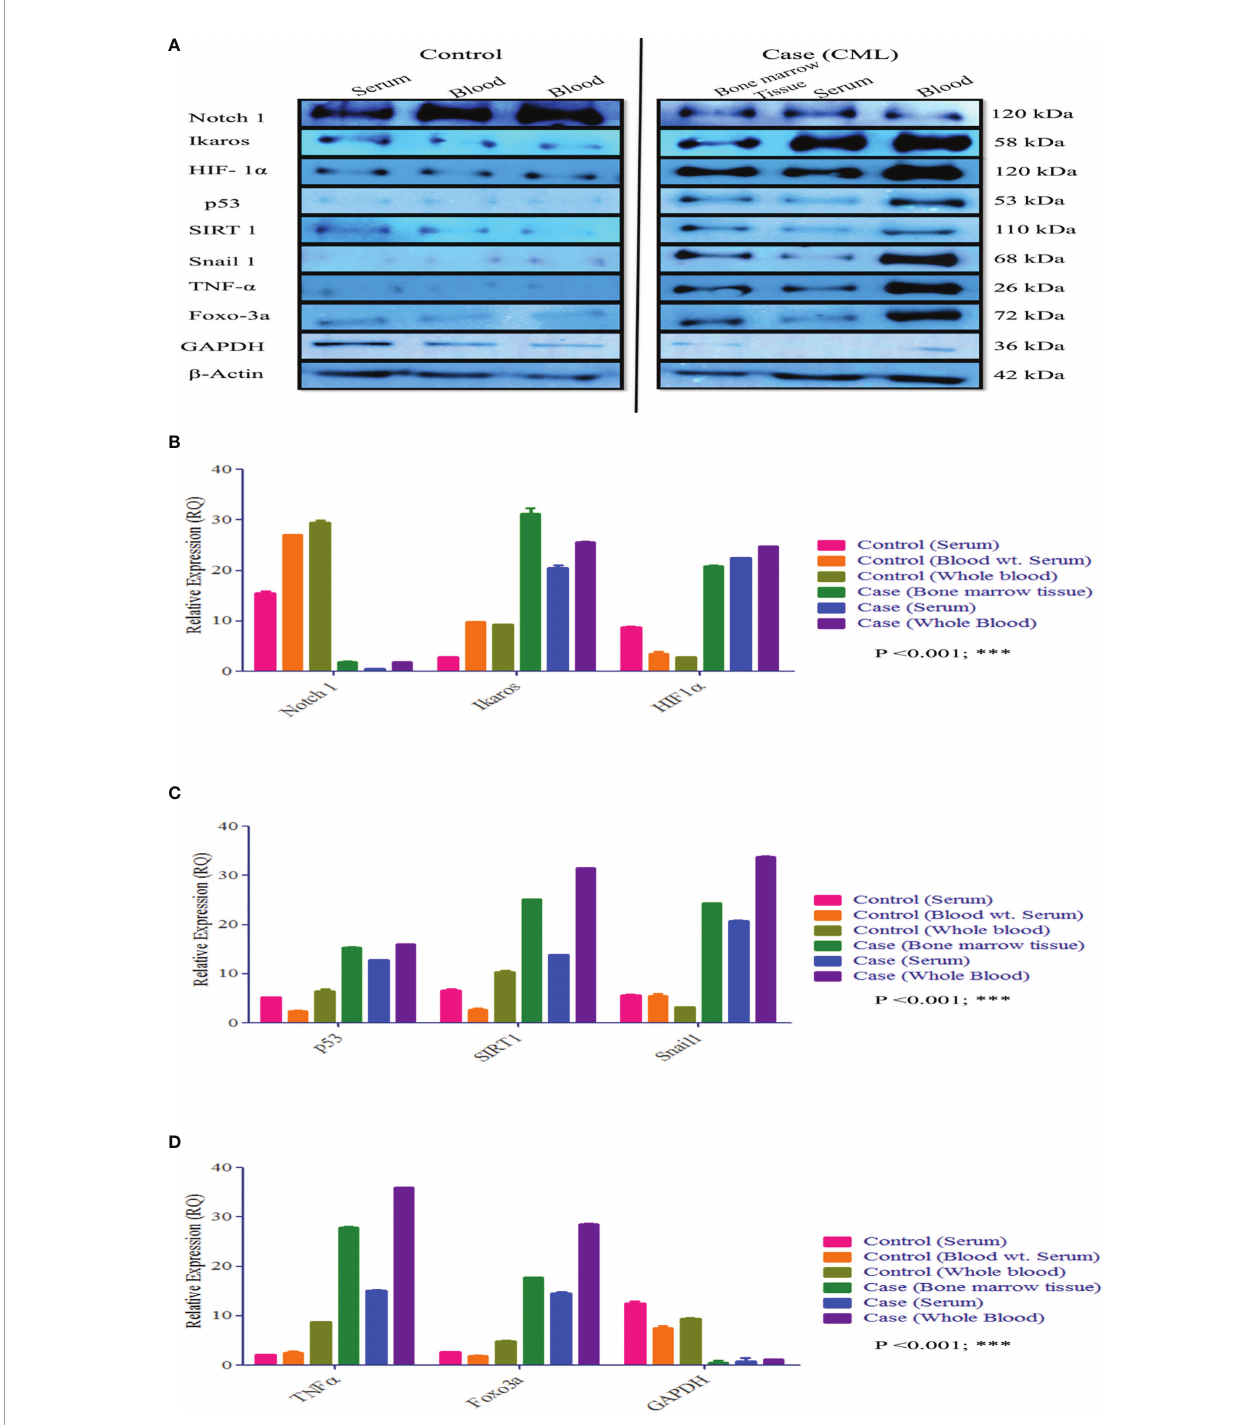
FIGURE 5 | Protein expression of HIF1 a , Notch1, and their associated genes in CML. (A – D) Western blot and densitometric analysis of the proteins. In healthy controls, we performed Western blotting in blood and serum, wherein CML was performed Western blotting in bone marrow tissue, serum, and blood and compared all the results with healthy controls. All quantitative data are mean ± SD, ***p<0.001,